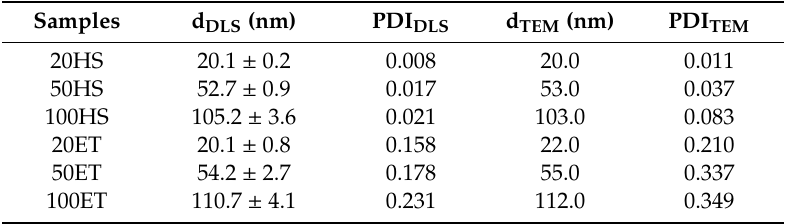
Table 1. Properties of SNPs. HS: hydrophilic particle. ET: with ethyl functional group modified particle. Size represented as mean ± SD of three parallel syntheses. The numbers refer to the particle